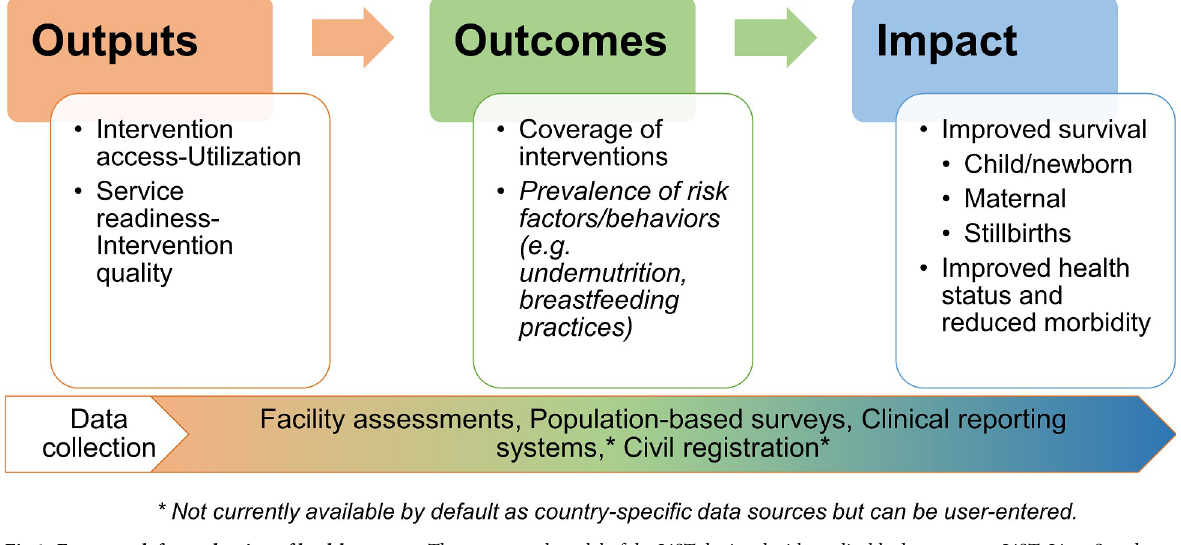
Fig 1. Framework for evaluation of health systems. The conceptual model of the LiST depicted with applicable data sources. LiST, Lives Saved Tool.